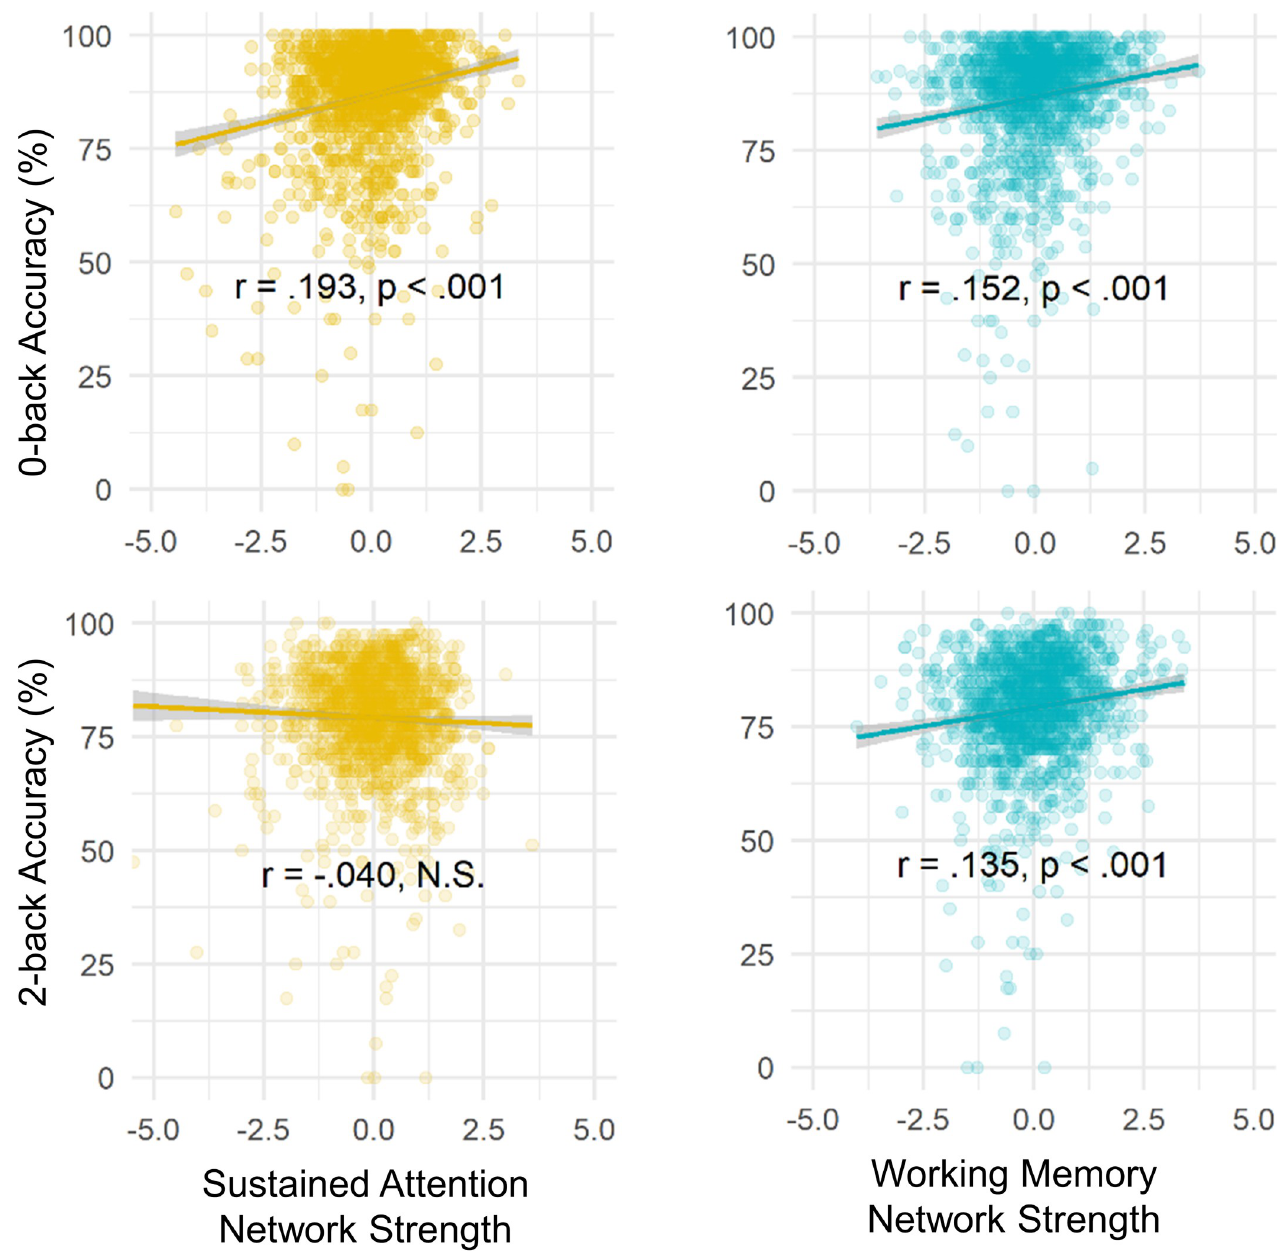
Fig 4. Strength of adult SA and WM networks in preadolescents predict respective task performance. Correlations between SA (left, golden) and WM (right, blue) network strength and children’s 0-back (top) and 2-back (bottom) task performance. The data for this figure are available at NDA study 1849 10. 15154/1528288. SA, sustained attention; WM, working